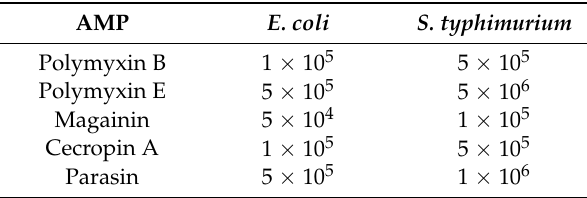
Table 3. Limits of detection (LoD) (CFU/mL) of different types of AMPs for the detection of E. coli and S.